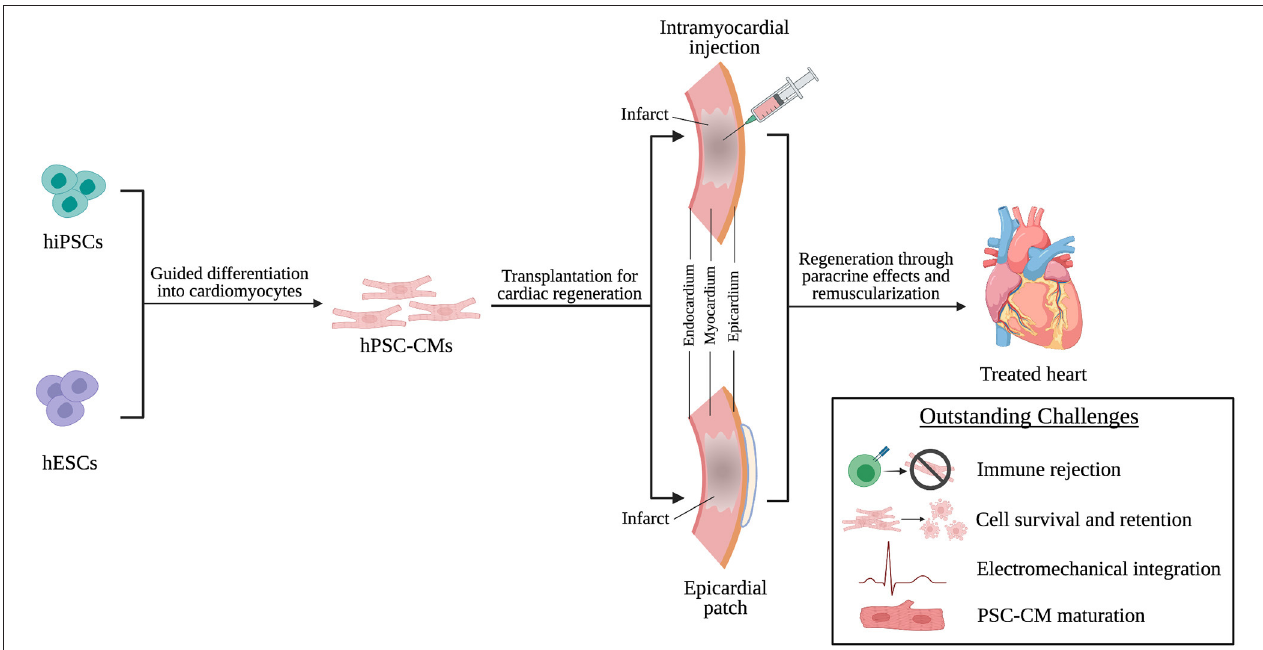
FIGURE 1 | hPSC-CMs are differentiated from hiPSCs and hESCs and transplanted into the infarcted heart through intramyocardial injection or epicardial patches as a cardiac regenerative therapy. Following transplantation, regeneration is driven by paracrine effects of and remuscularization of myocardial tissue by engrafted hPSC-CMs. However, challenges persist that limit successful transplantation of hPSC-CMs and will need to be addressed to achieve effective clinical